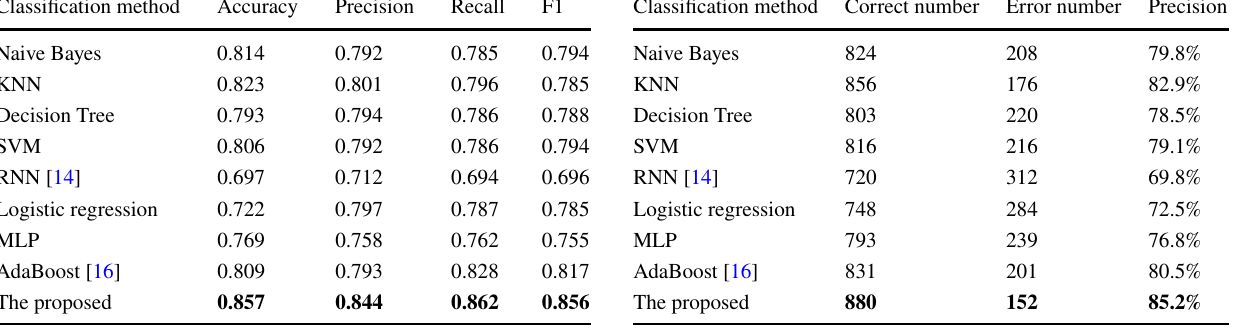
Table 4 Comparison of grouping effects Classification method